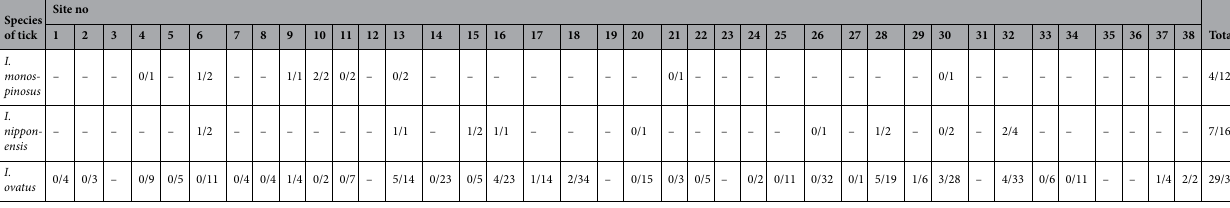
Table 5. Prevalence of rickettsial genes detected from adult ticks by collection sites. The Northern (Kaetsu), Central (Chuetsu) and Southern (Joetsu) areas of Niigata Prefecture corresponds to the collection sites 1 to 13, 14 to 30, and 31 to 36, respectively. Sado Island area corresponds to the collection sites 37 and 38.